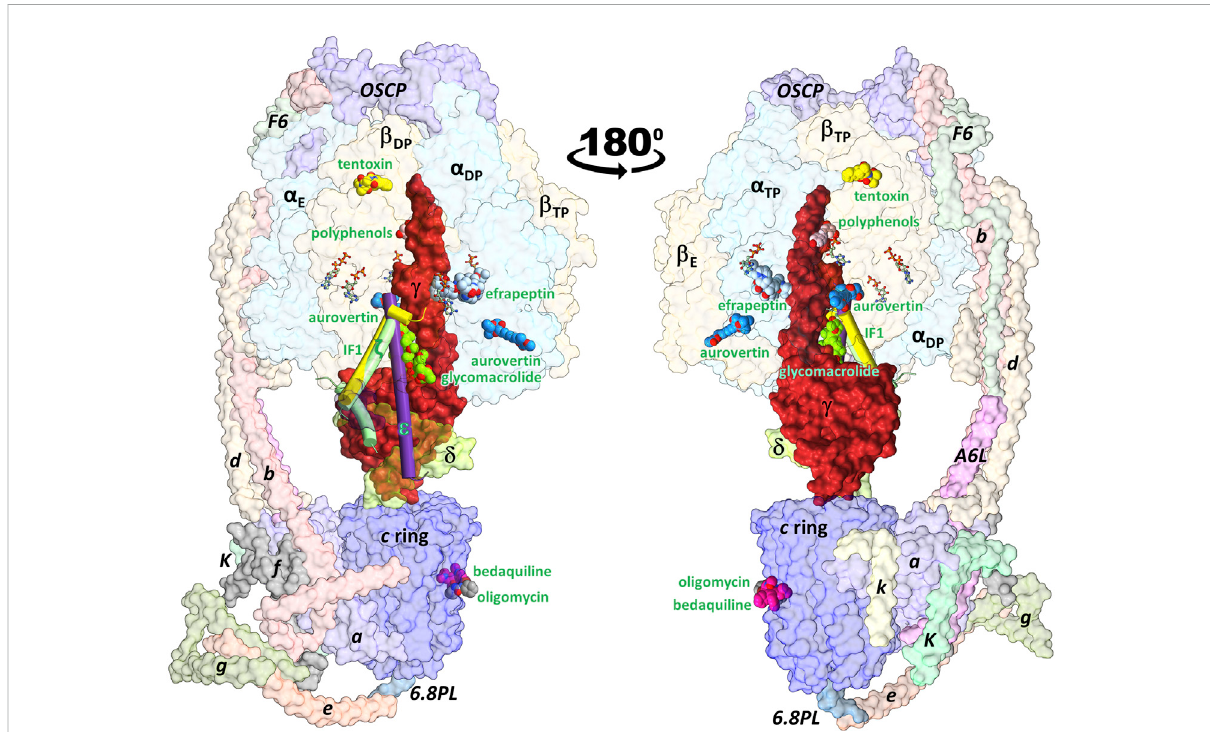
FIGURE 1 Schematic representation of the ATP synthase architecture and the binding sites of exogenous and endogenous allosteric inhibitors. Inhibitors whose3DstructureincomplexwiththeenzymehasbeensolvedexperimentallyweresuperimposedonthecryoEMstructureoftheporcineenzyme in an inhibited conformation by the IF1 subunit (PDB ID: 6j5i). The minimal structures of F 1 and F O subcomplexes are composed of the α 3 β 3 γδε and ab 2 c 8-17 subunits,respectively.EukaryoticATPsynthasescontainsupernumerarysubunits,mainlyintheF O sector.F O F 1 -ATPsynthaseinhibitors can be classi fi ed as endogenous or exogenous. The endogenous inhibitory ε (PDB ID: 6oqr (Sobti et al., 2020)), ζ (PDB ID: 5dn6 (Morales-Rios et al., 2015)) and IF1 (PDB ID: 6j5i (Gu et al., 2019)) subunits are shown in purple, green and yellow cylinders, respectively. The exogenous inhibitors aurovertin B (PDB ID: 1cow (van Raaij et al., 1996)), resveratrol (PDB ID: 2jiz (Gledhill et al., 2007a)), tentoxin (PDB ID: 1 kmh (Groth and Pohl,